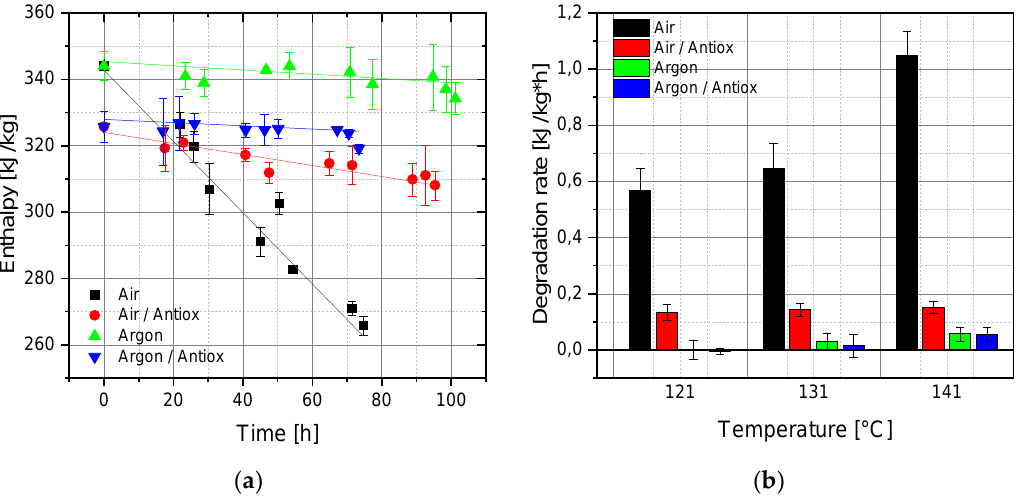
Figure 3. ( a ) Evolution of latent heat values over time during the short-term experiment at 141 °C. ( b ) Latent heat degradation rate for short-term tests at three different temperatures.